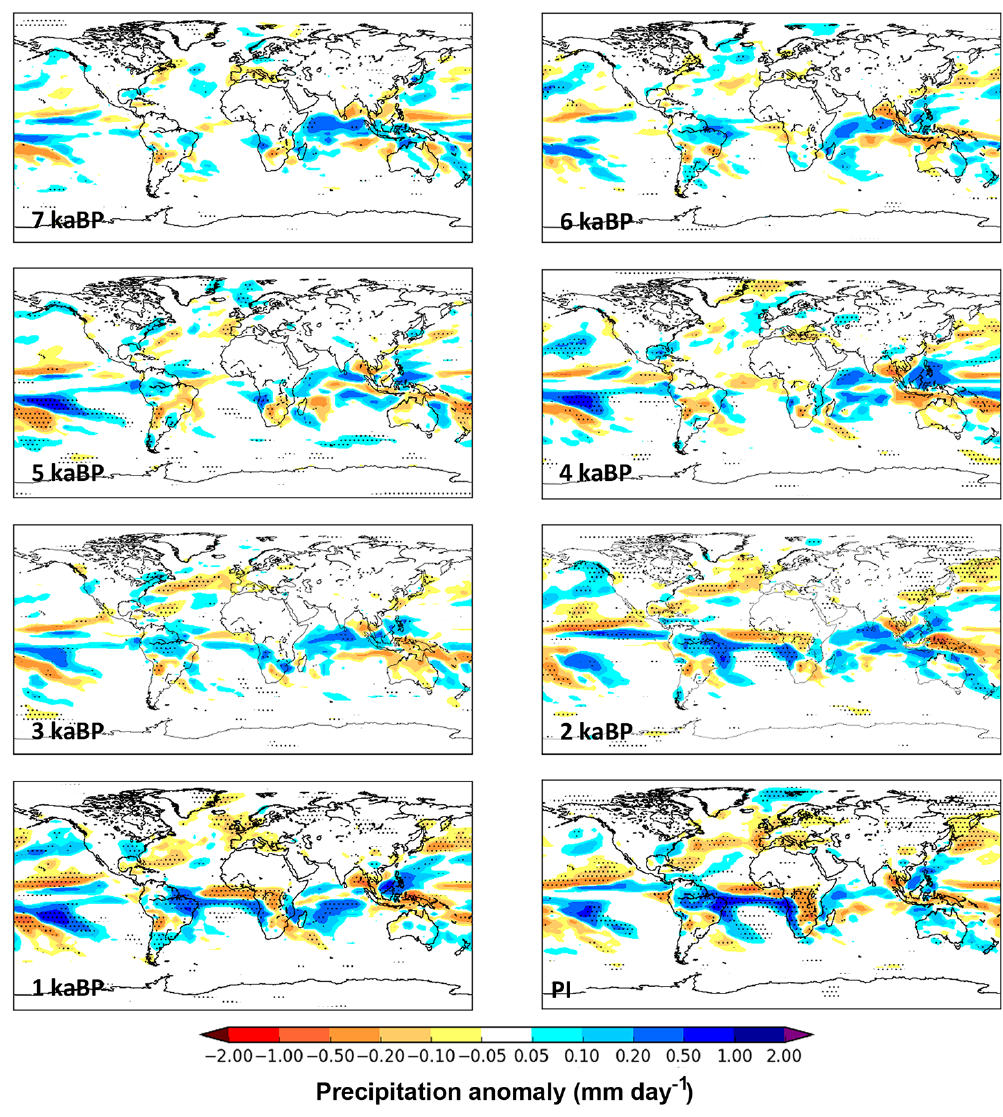
Figure 9. DJF precipitation anomalies (mmday − 1 ) for KK10 minus control at time slices from the late pre-industrial period (1850CE) to 7kaBP. The stippling indicates grid boxes where the anomalies are significant at the 95% level using Wilcoxon rank sum statistical